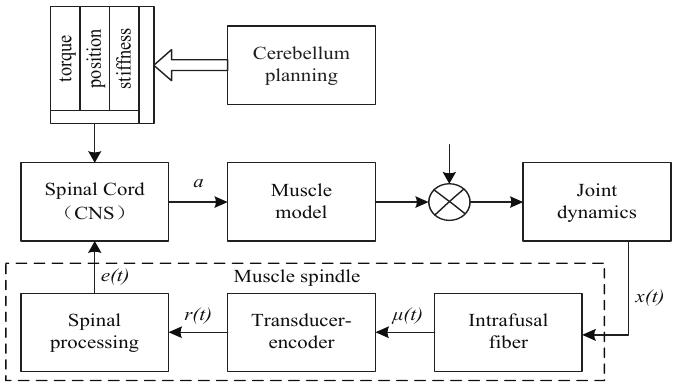
Figure 2. Biology structure of musculoskeletal